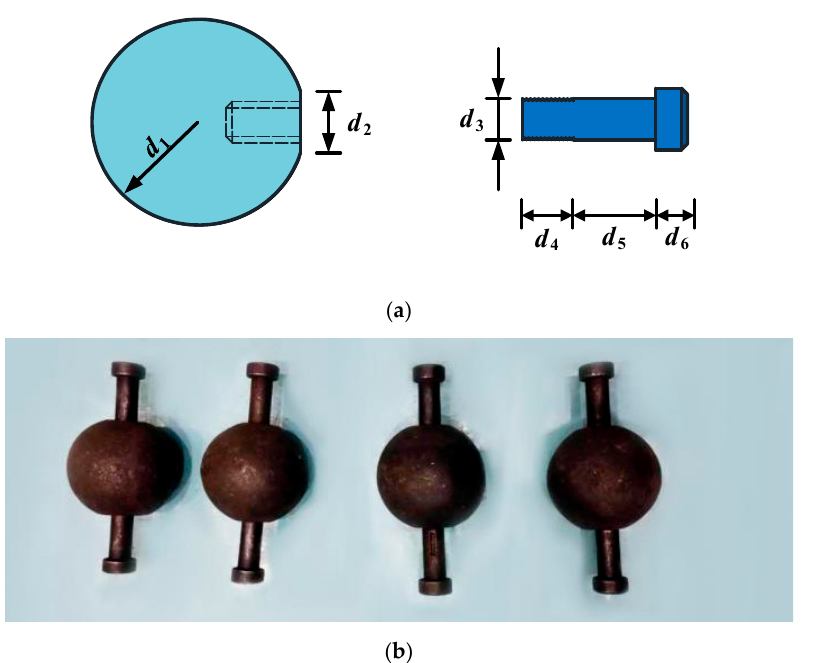
Figure 2. Bolt-sphere connections: ( a ) schematic of component dimensions; ( b ) typical bolt-sphere connections.